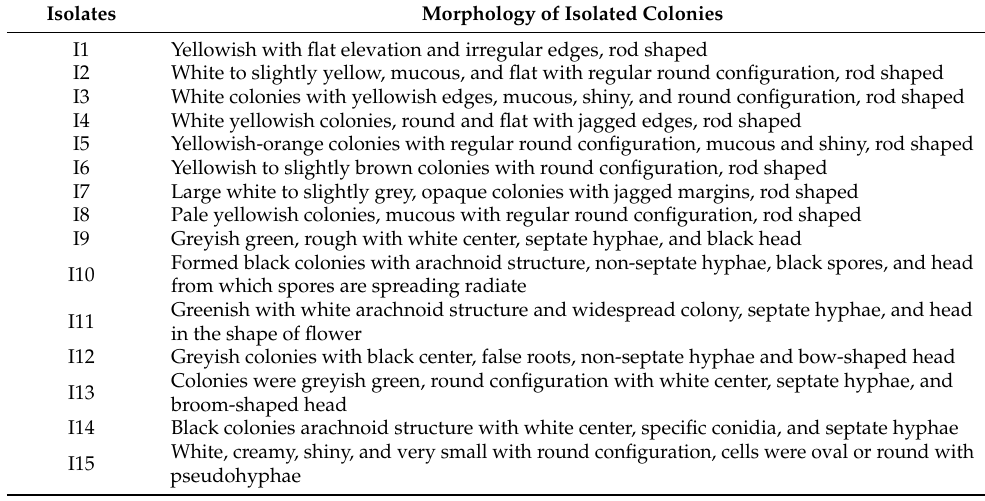
Table 3. Morphology of isolated colonies, I1–I15.